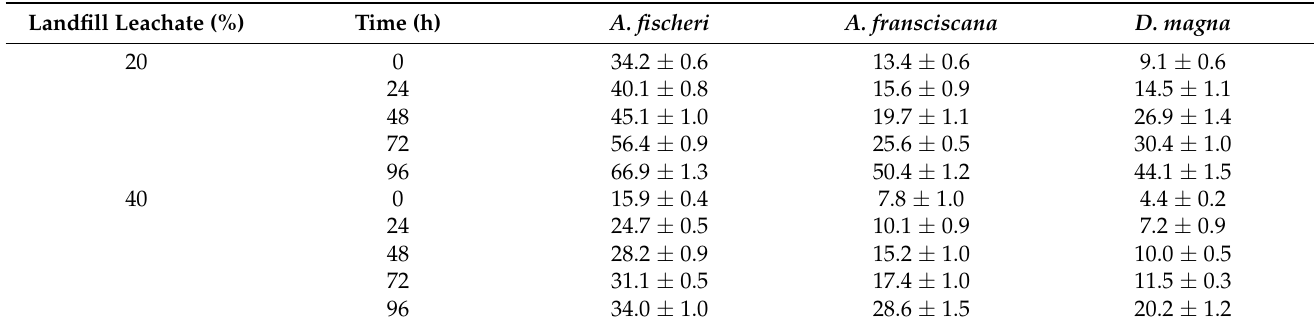
Table 4. Ecotoxicity data (EC50 and LC50 values) for D. magna , A. franciscana, and A. fischeri assays in the presence of post-culture filtrates treated with the landfill